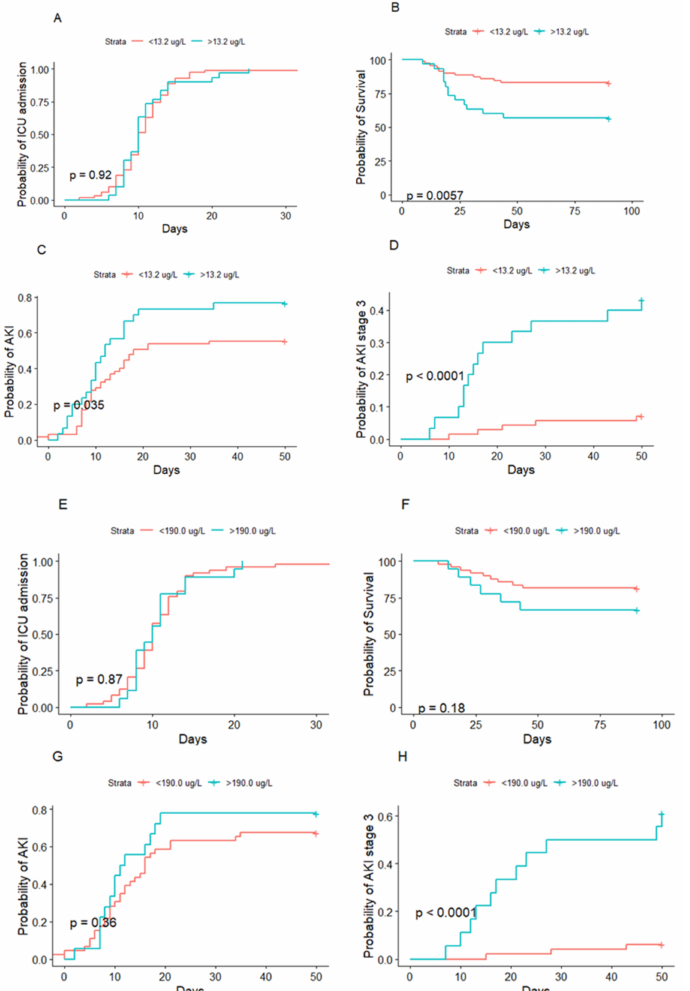
Figure 3. Probability of admission to intensive care, acute kidney injury of any stage, and stage 3 development, as well as mortality vs. human neutrophil lipocalin in plasma at admission ( A – D ) and vs. peak concentrations of human neutrophil lipocalin in whole blood ( E – H ) during intensive care. ROC in conjunction with Youden’s J statistic were calculated to find suitable cutoff values for HNL in plasma and whole blood. Since the primary focus was severe AKI development, a cutoff close to that calculated from AKI stage 3 was applied to all four outcomes in the figure. The concentrations used were 13.2 µ g/L and 190 µ g/L for P-HNL Dimer and peak B-HNL, respectively. Kaplan–Meyer curves were than calculated for ICU admission ( A , E ), survival ( B , F ), AKI ( C , G ), and AKI stage 3 ( D , H ). Time to ICU admission was not different in the groups above and below the cutoffs for P-HNL Dimer or B-HNL ( p = 0.92 and p = 0.87). The cumulative risk of death, developing AKI of any stage and AKI stage 3 were higher if above 13.2 µ g/L in plasma at admission ( p = 0.0057, p = 0.035, and p < 0.0001, respectively). The cumulative risk of death or developing AKI did not differ between those above or below 190.0 µ g/L B-HNL ( p = 0.18 and p = 0.36, respectively); however, the cumulative risk of developing AKI stage 3 was greater in the patients above the cutoff ( p <